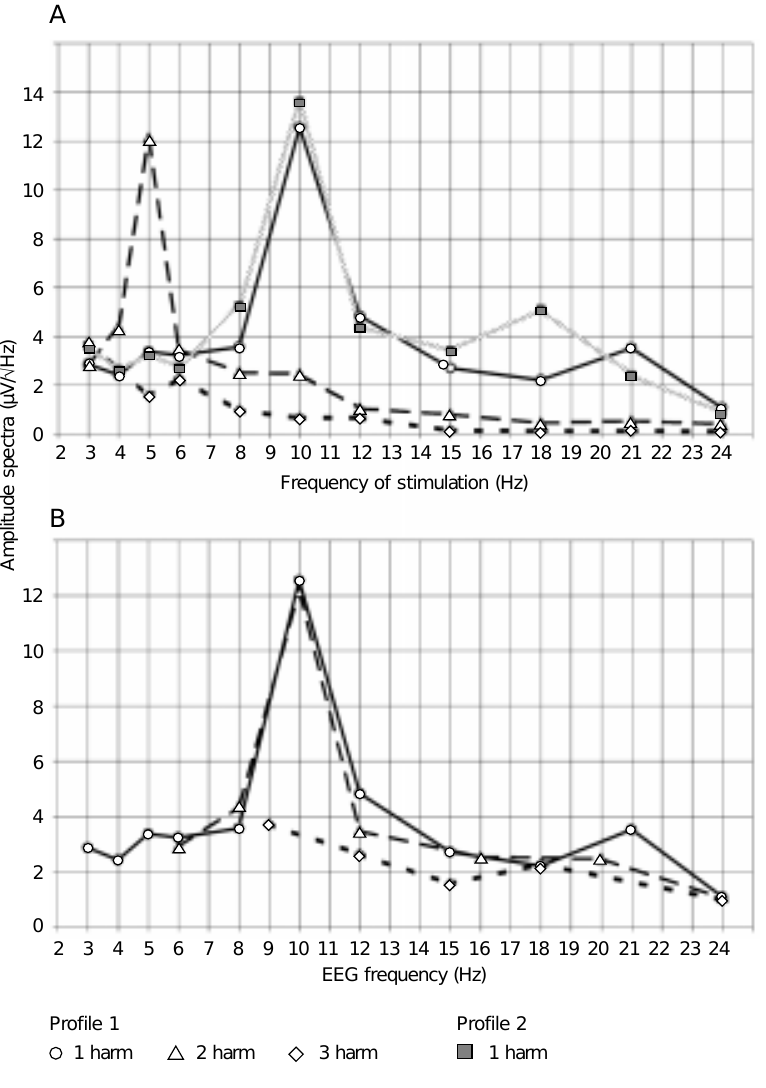
Figure 1. An example of individual driving profiles (subject TG), constructed by combining (cid:214) the amplitude spectra (in µV/ Hz 1 ) obtained during stimulation at different frequencies. A , Profiles for the first (Profile 1) and second (Profile 2) series of intermittent photic stimulation (IPS). For the first series, the profiles for the first three harmonics (1, 2 and 3 harm) are given. For the second series, only that of the fundamental one is shown. The abscissa shows the frequency of stimulation, in Hz. B , Profiles for the first three harmonics of the first IPS series (as used in Figure 1A), but with the abscissa showing the EEG frequency, in